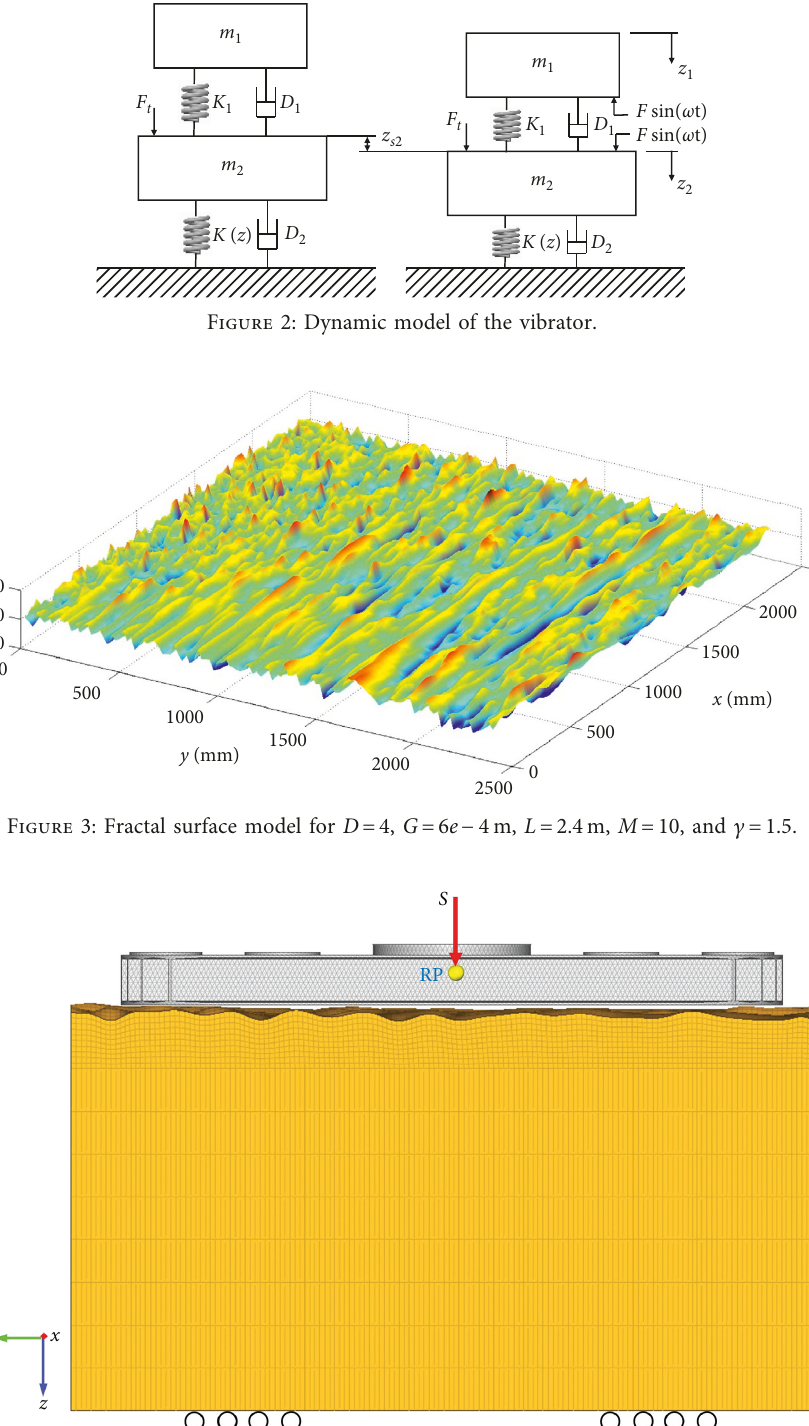
Figure 4: Finite element model of the contact interfaces.